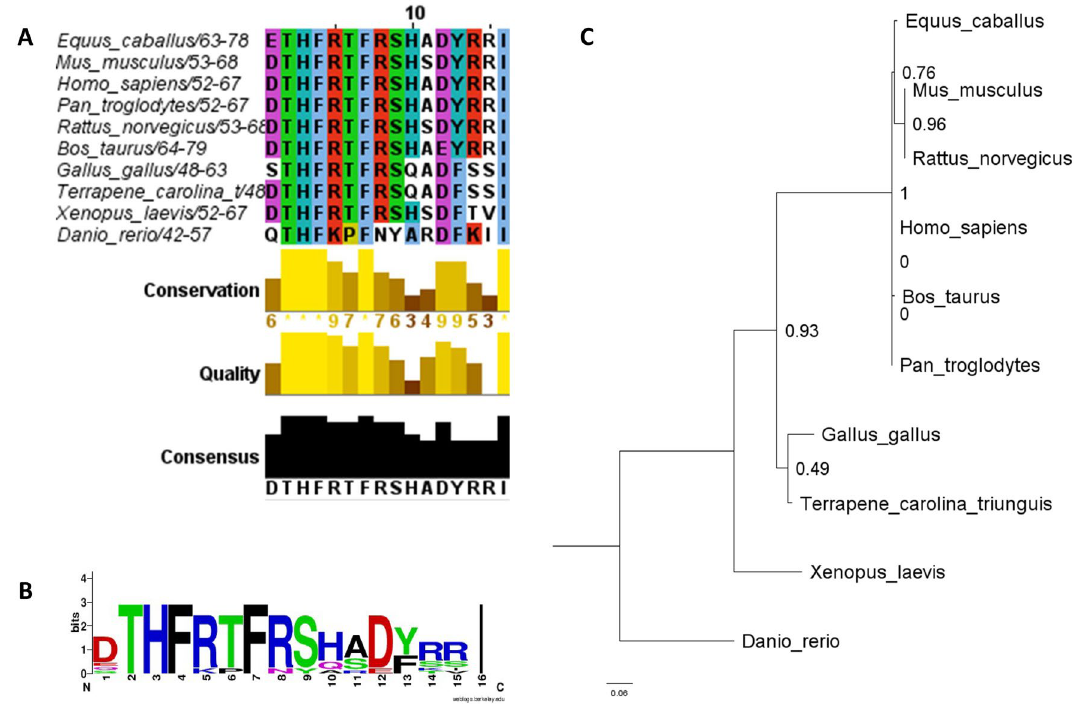
Figure 1. SOCS1 KIR Is Highly Conserved Among Vertebrates. ( A ) Multiple sequence alignment of 10 vertebrate SOCS1 sequences at the kinase inhibitory region (KIR) was retrieved from the National Center for Biotechnology Information’s (NCBI’s) protein database and aligned using PRABI’s MULTALIN tool. The residues were highlighted using the ClustalX coloring scheme. The amino acids contained within the KIR were evaluated according to conservation, quality, and consensus. ( B ) The sequences of the 10 vertebrate SOCS1 KIR domains, trimmed using Berkeley’s Web Logo tool, were used to generate a logo of the consensus sequence. ( C ) Full length SOCS1 from 10 different vertebrate species were used to generate a phylogenetic tree using